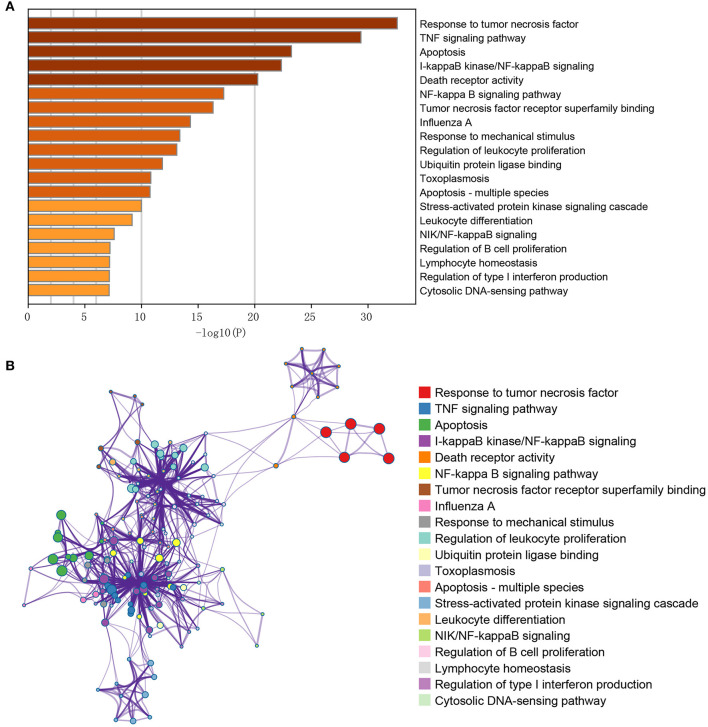
GO/KEGG pathway enrichment cluster interaction analysis of the differentially expressed genes. (A) The X-axis represents the gene ratio (–log10); the Y-axis represents the different items of functions or pathways. (B) The interactive network among terms; different node colors indicated different clusters, and lines indicated gene similarities among terms.